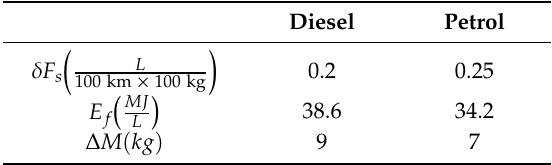
Table 13. BED (km) vs. CISC for various types of engine blocks and manufacturing